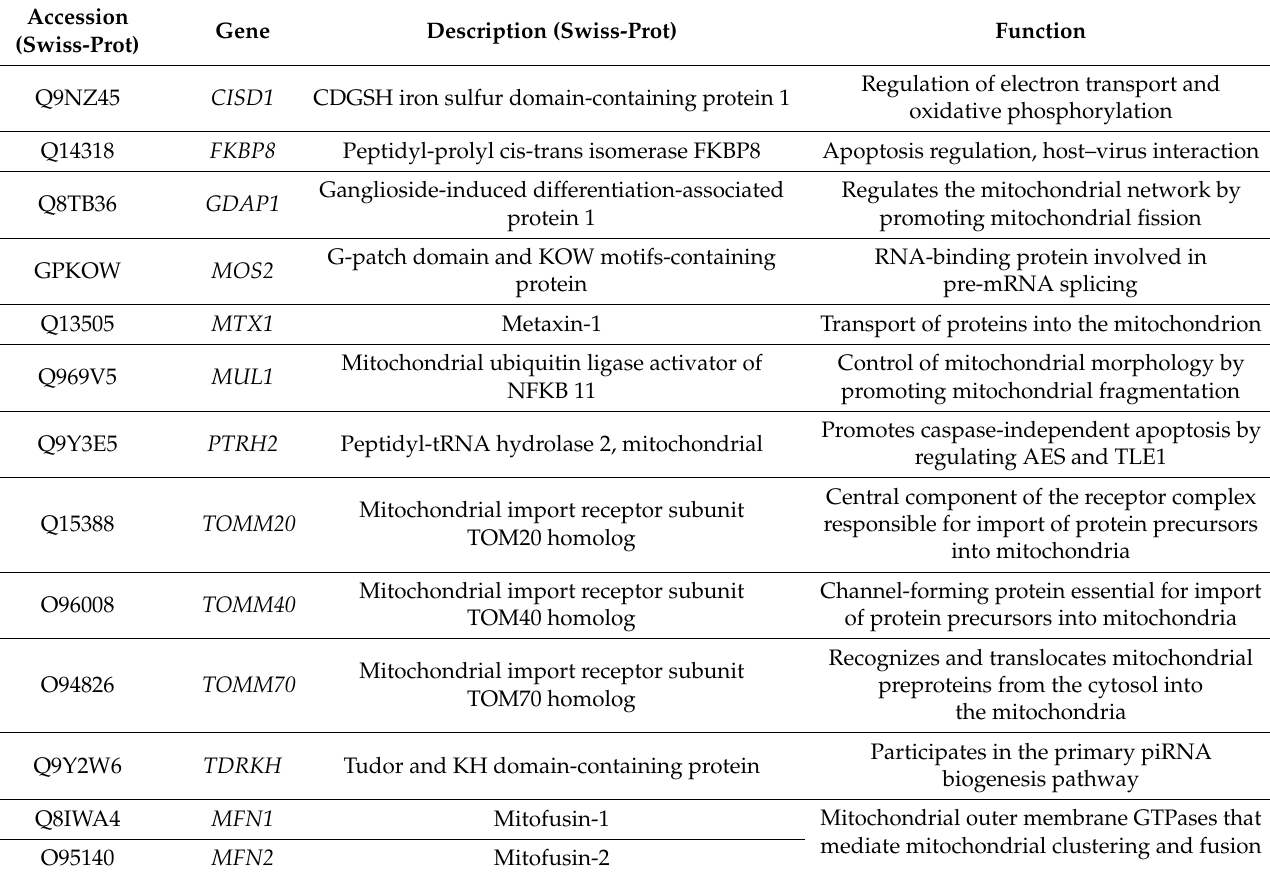
Table 3. Atypical ubiquitination of mitochondrial proteins